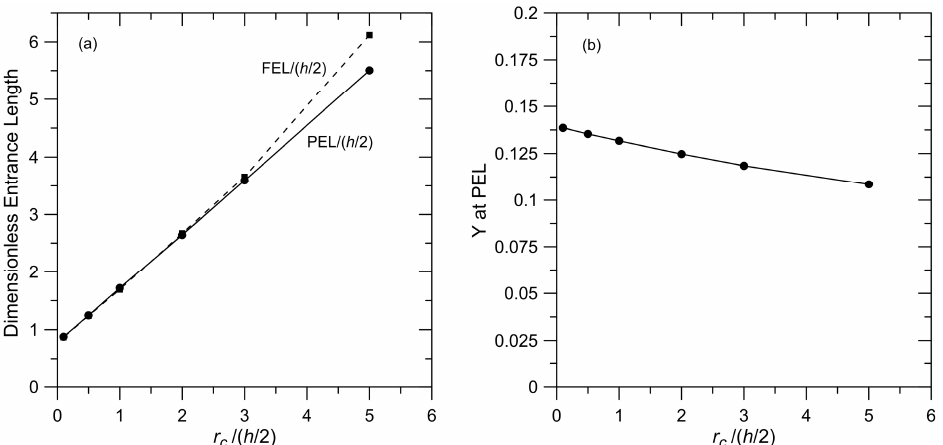
Figure 7. Effect of the radius of curvature at the pore mouth on ( a ) PEL and fluid entrance length (FEL) and ( b ) Y at the PEL. Results are shown for a system with λ = 0.1, particle specific gravity = 1.1, Y initial = 1 and X initial = − 5.